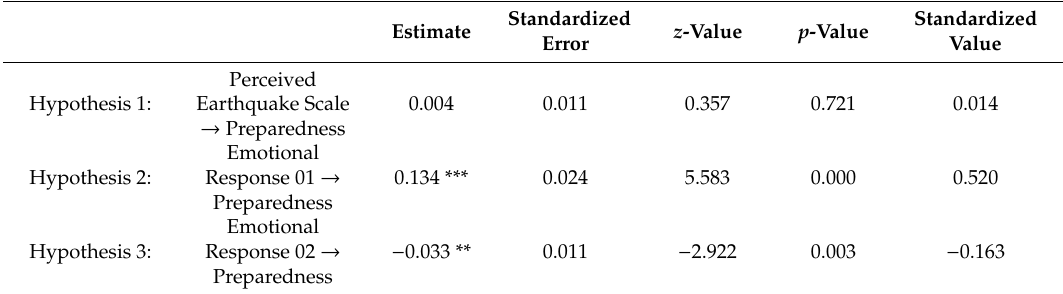
Table 5. Hypothesis Testing Results and Unstandardized Path Loadings ( n =